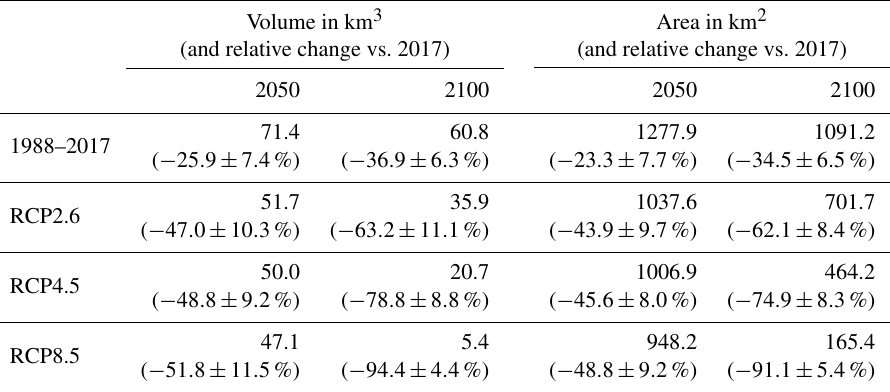
Table 1. Overview of multi-model mean future glacier evolution based on RCM simulations from the EURO-CORDEX ensemble. The evolution under the mean SMB obtained from the 1988–2017 climatic conditions represents the committed